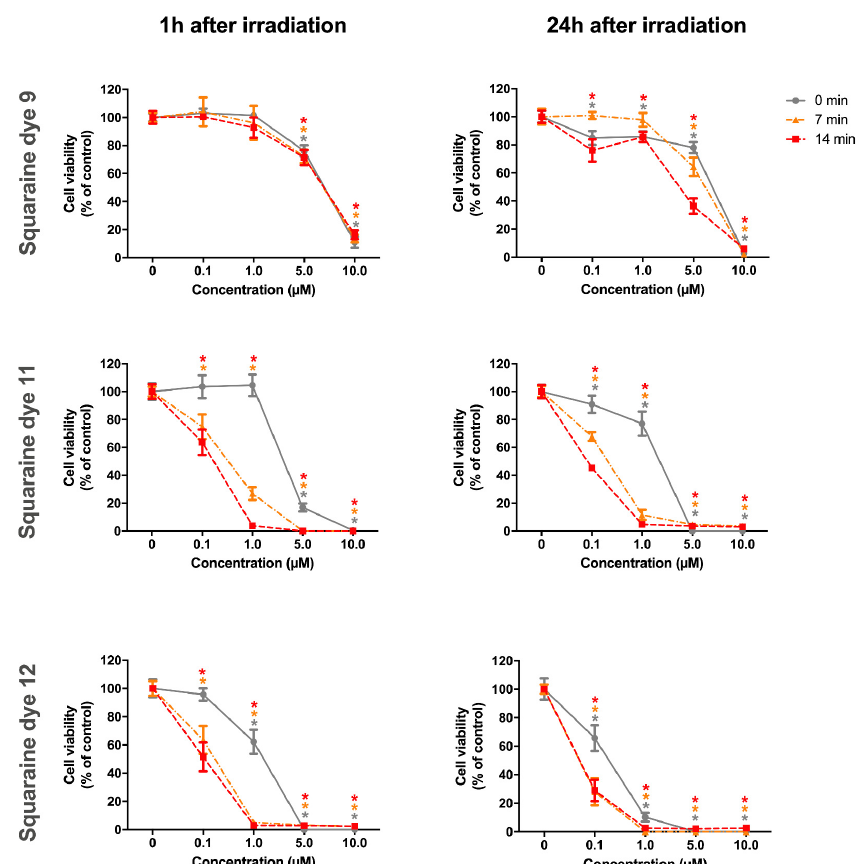
Figure 5. Antiproliferative effects of photodynamic treatment on MCF-7 cells. MCF-7 cells were exposed for 24 h to the quinoline- and benzoselenazole-derived unsymmetrical squaraine cyanine dyes 9 , 11 and 12 , at indicated concentrations, and then subjected to light-treatment using a light-emitting diode system 0, 7, or 14 min (see methods for details). After contact with the irradiated dyes for 1 h or for 24 h, cell viability was assessed. Cell viabilities are expressed as the percentage of control, non-treated cells (0 µM), and presented as mean value ± standard error of three independent experiments (each one in quadruplicates). Student’s t -test statistical significant treatments related to the non-treated condition ( p -value < 0.05) are evidenced by an asterisk (*) of the color relative to the irradiation time.